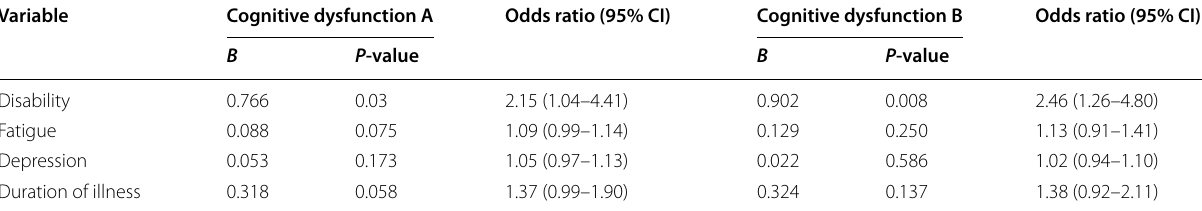
Duration of A Cognitive dysfunction without adjustment = B Cognitive dysfunction with adjustment of age, gender, and education =